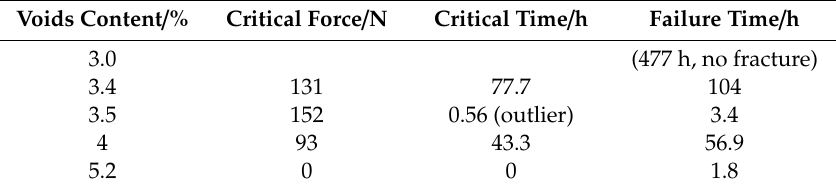
Table 3. The relationship between the critical fracturing time, the critical fracturing pressure, and the voids content of the specimen.